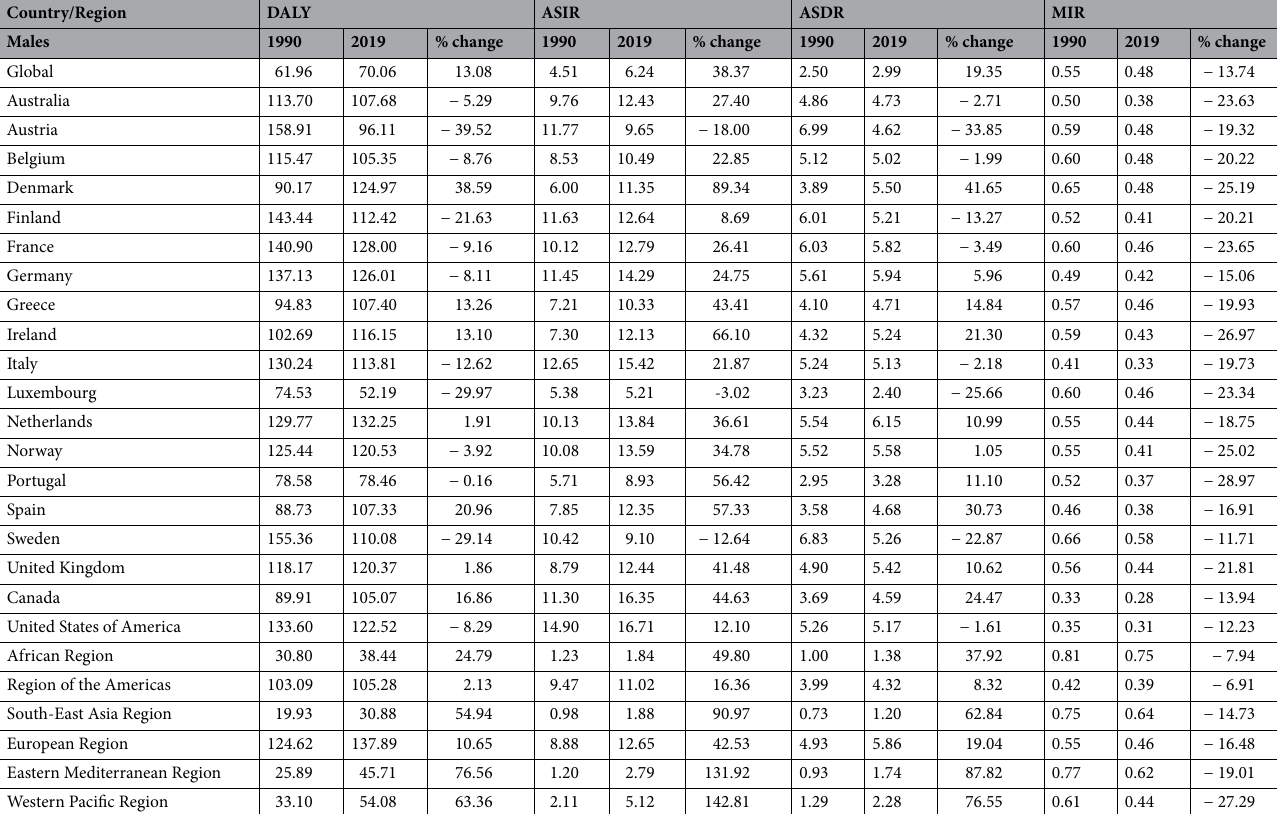
Table 2. 1990 and 2019 male age-standardized mortality rates (ASMRs), age-standardized incidence rates (ASIRs), mortality-to-incidence ratios (MIR), and disability-adjusted life years (DALYs), with